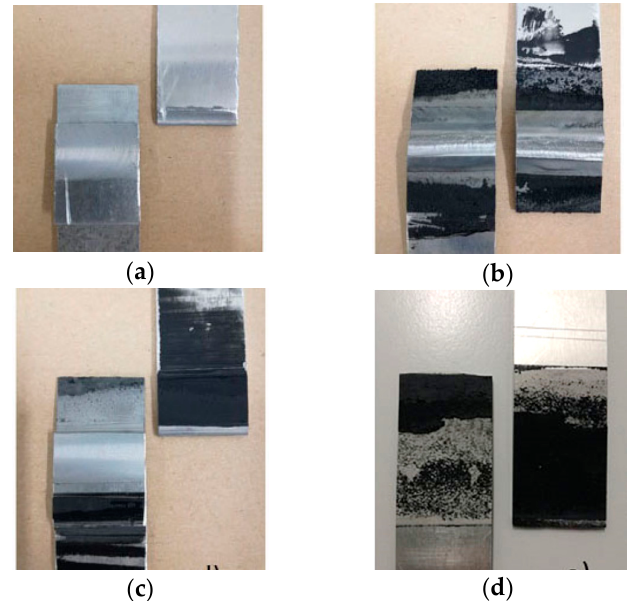
Figure 6. Fracture surfaces of: ( a ) FSW joints; ( b ) FSWB-WT joints; ( c ) FSWB-FI joints; ( d ) AB joints.